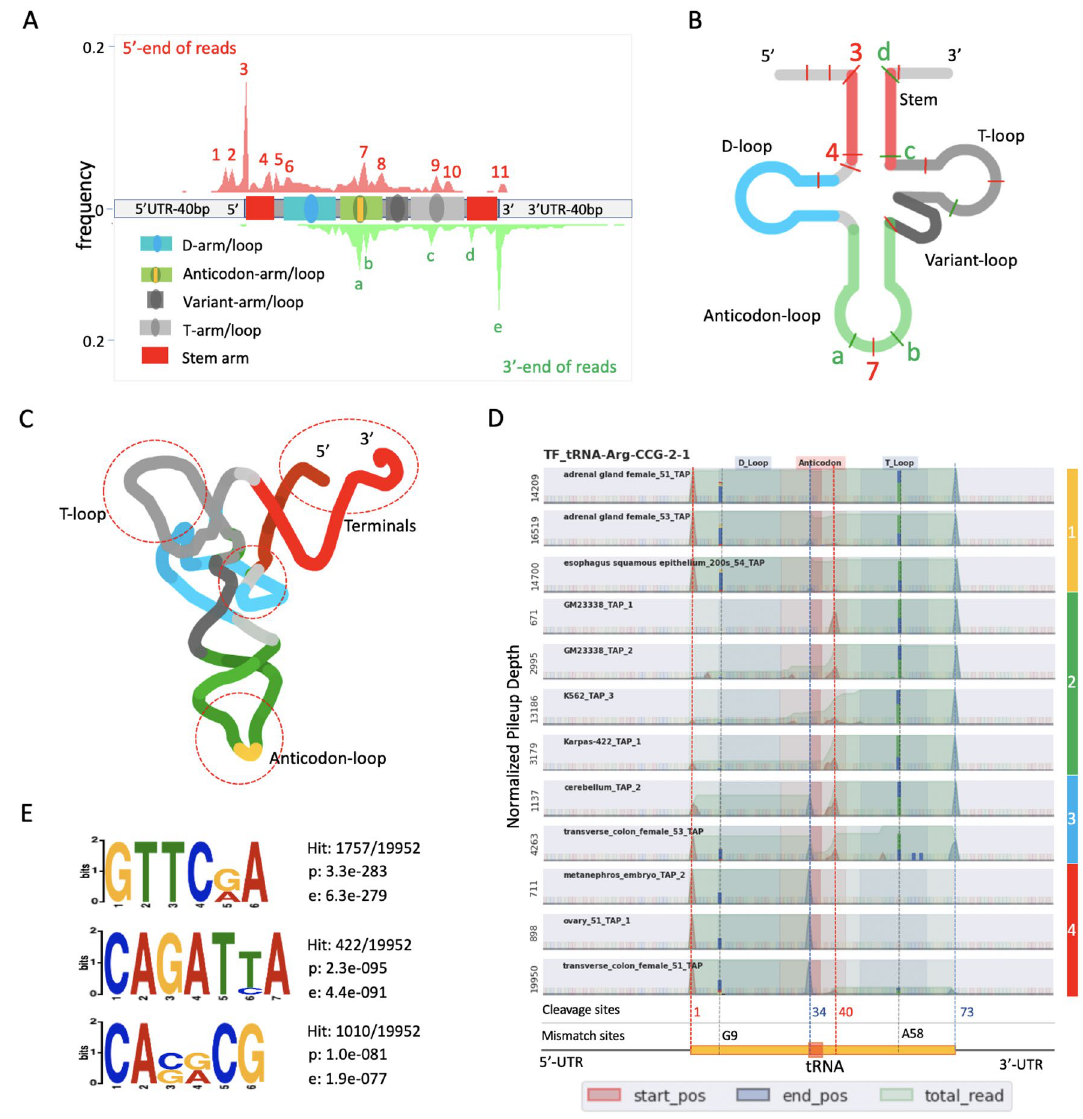
Figure 7. The cleavage sites of tRNAs. ( A ) The accumulated distribution of the cleavage sites on a virtual tRNA. The red and green area plots denote the accumulated frequencies of the 5 ′ and 3 ′ ends of tRFs (including ± 40 bp from these regions) in all samples. The arms and loops of tRNAs are shown as indicated in the legend. The cleavage hot spots are labeled as numbers (5 ′ -end) and letters (3 ′ -end). ( B ) Cartoon representation of the tRNA secondary structure with all cleavage hot spots labeled in Fig. 6A. ( C ) Cartoon representation of tRNA 3D structure with the hot cleavage regions highlighted by dotted circles; ( D ) The pileup profiles of tRNA-His- CCG-2-1 in 12 samples. The red and green peaks and dotted lines indicate the mapping locations of the 5 ′ ends and 3 ′ ends of the reads and potential cleavage sites, respectively. Light green area plots (total reads) are the pileup profiles of the tRNA-related reads. The numbers on the Y-axis represent the normalized pileup depth. The regions of the tRNA body and anticodon are represented by orange and light-red blocks. The color bars on the right side indicate the classes of RNA-Seq profiles. ( E ) The top three motifs enriched in the tRNA cleavage sites identified by the DREME tool. Hits correspond to the ratio of matched sequences to the total number of sequences. The p-value corresponds to the p-value of Fisher’s exact test for enrichment of a motif in the positive sequences, and e is the motif p-value times the number of candidate motifs